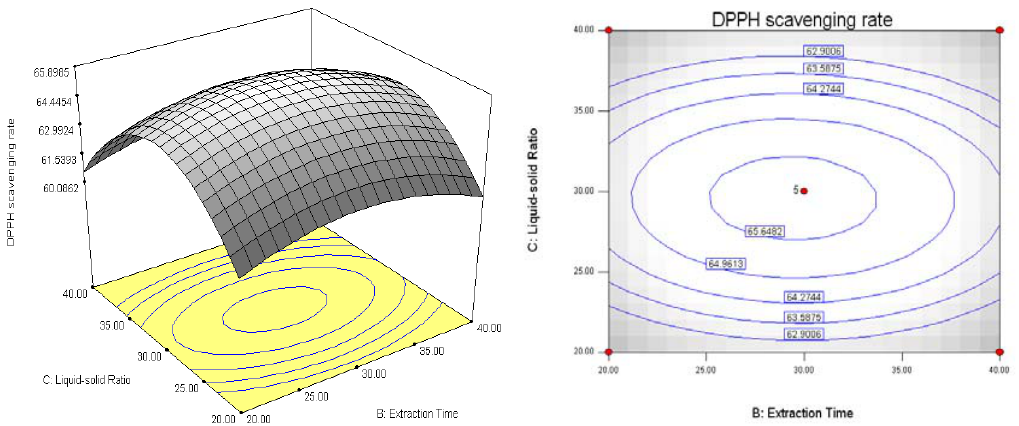
Figure 6. Response surfaces and contour plots showing the effects of extraction time and liquid-solid ratio on antioxidant activity Y = (B,